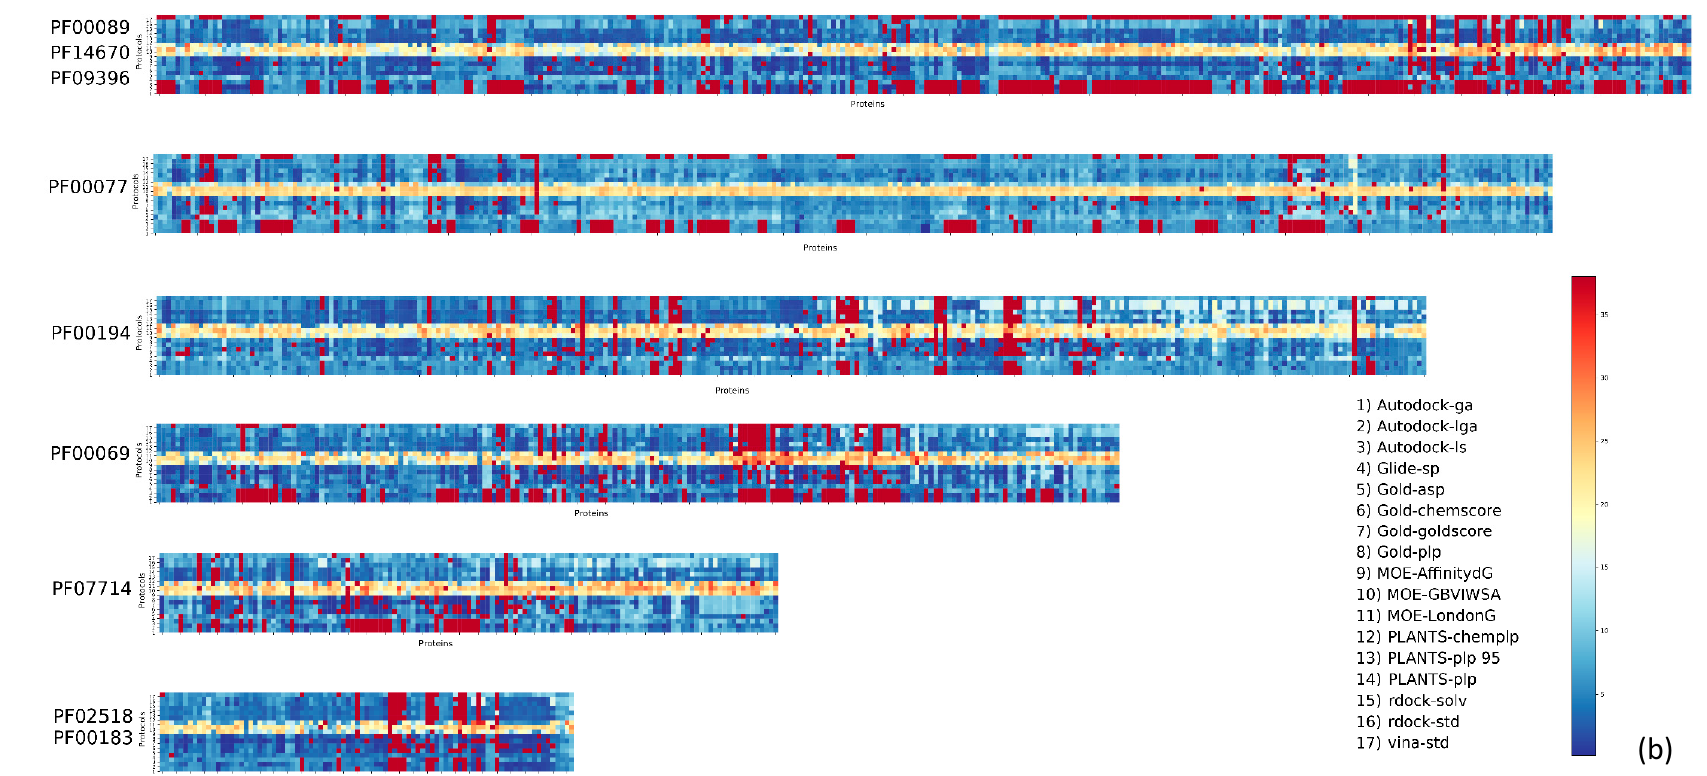
Figure 2. DockBench Results divided by Pfam protein families. The heatmaps are color-coded according to the RMSD ave . The ten families in panel (a) are: PF00439, Bromodomain; PF10613, Ligated ion channel L -glutamate and glycine-binding site; PF00102, Protein tyrosine phosphatases; PF000061 Lipocalin; PF00497, Bacterial extracellular solute-binding proteins family 3; PF00104, Hormone receptors; PF00026, Eukaryotic aspartyl protease Peptidase M_10; PF01048, Phosphorylase superfamily; and PF00233, 3'5'-cyclic nucleotide phosphodiesterases. In panel ( b ) the heatmaps are color-coded according to the Root Main Square Deviation (RMSD) ave . The six families are: PF00089 Trypsin, PF14670 Coagulation Factor Xa inhibitory site, PF09396 Thrombin light chain, PF00077 Retroviral aspartyl proteases, PF00194 carbonic anhydrases, PF00069 protein kinase, PF07714 tyrosine kinase, PF02518 GHKL domain, and PF00183 HSP90.